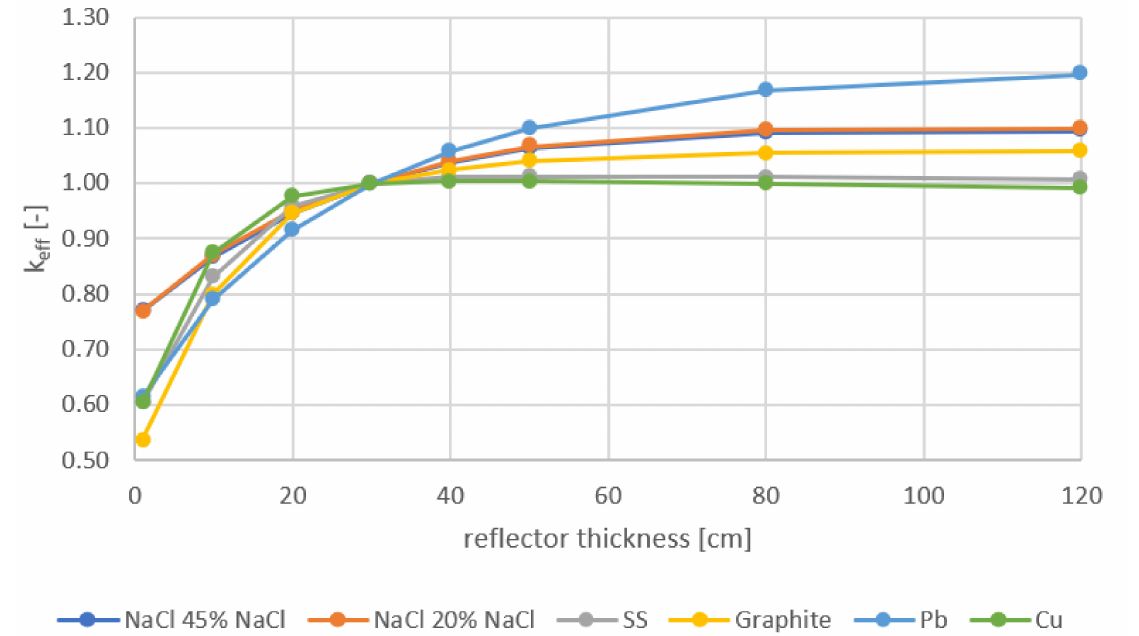
Figure 11. Criticality of the studied 2D system for different reflector thicknesses determined on the basis of the different critical core diameters for each reflector material with a 30 cm reflector and the following variations in the reflector